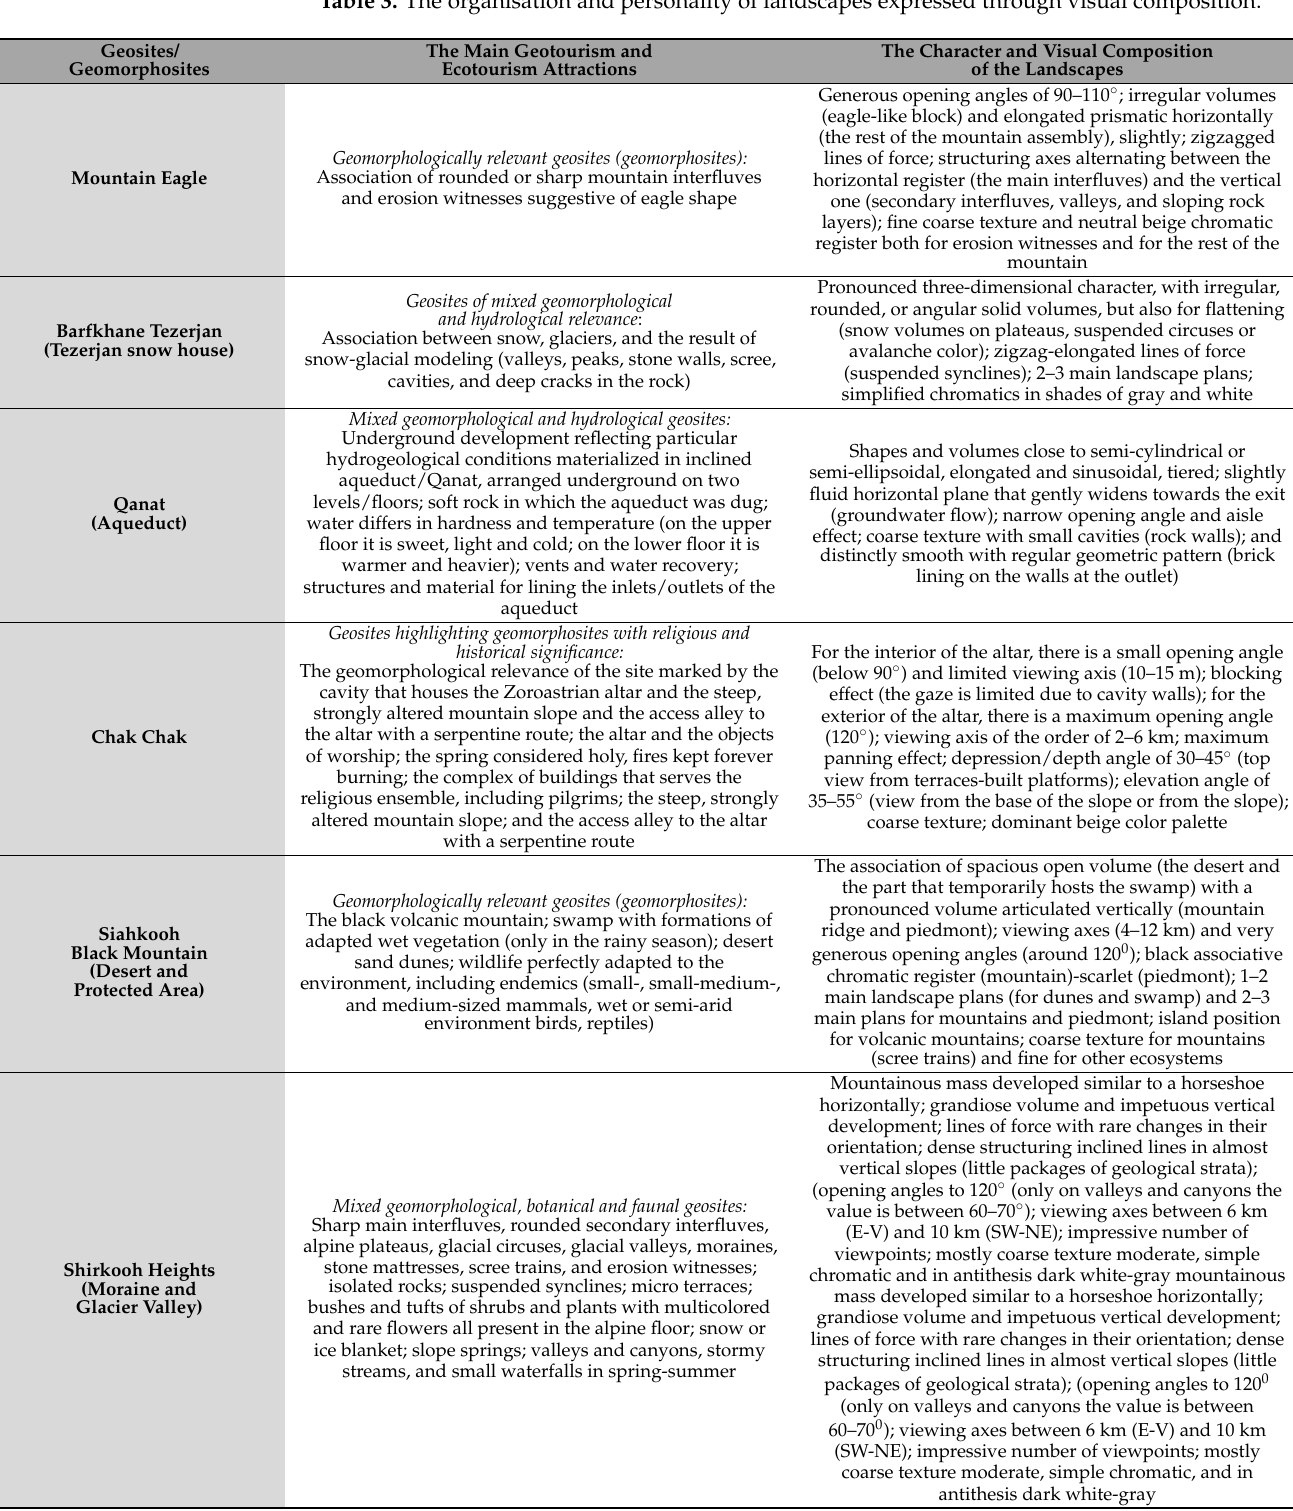
Table 3. The organisation and personality of landscapes expressed through visual